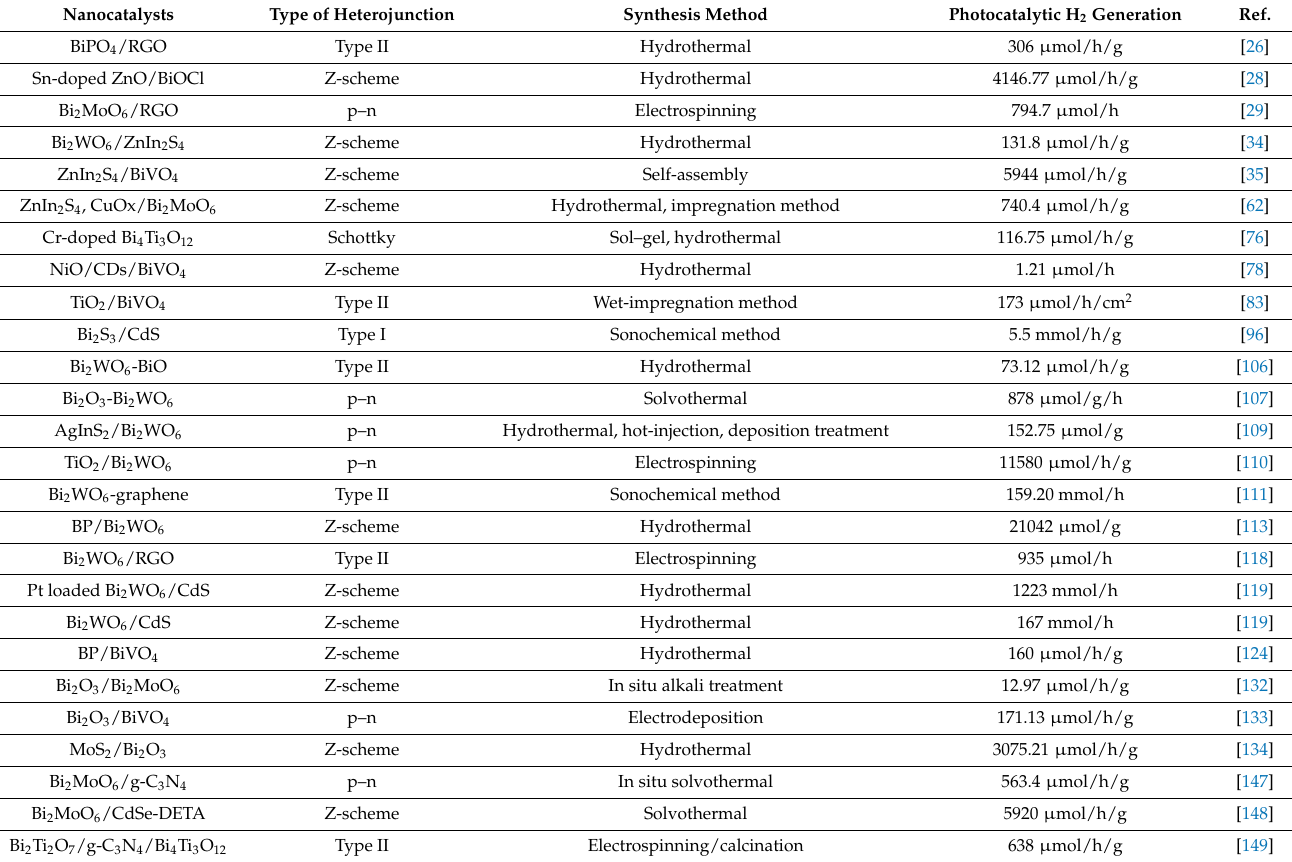
Table 1. Photocatalytic efficiency of Bi-based heterostructured nanocatalysts for HER